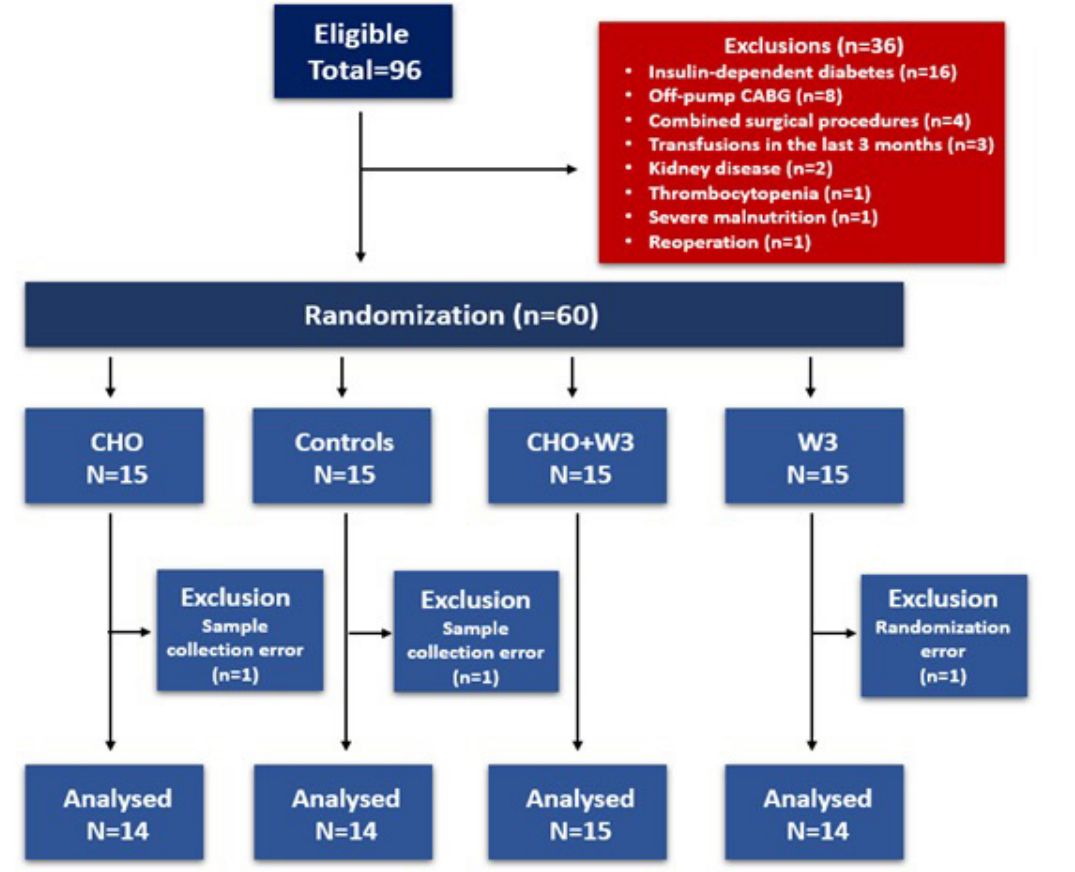
Fig. 2 - Flowchart showing patient selection for the